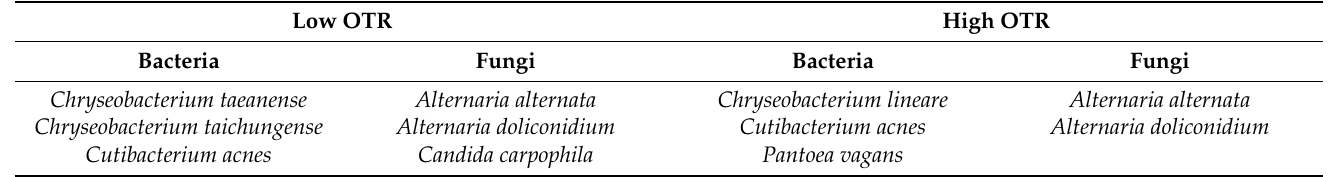
Table 1. Microorganisms isolated from ‘Pione’ grapes before storage and after storage in MA packag- ing flushed with either air or high CO 2 (10%, 15%, and 20%) for 8 days at 10 ◦